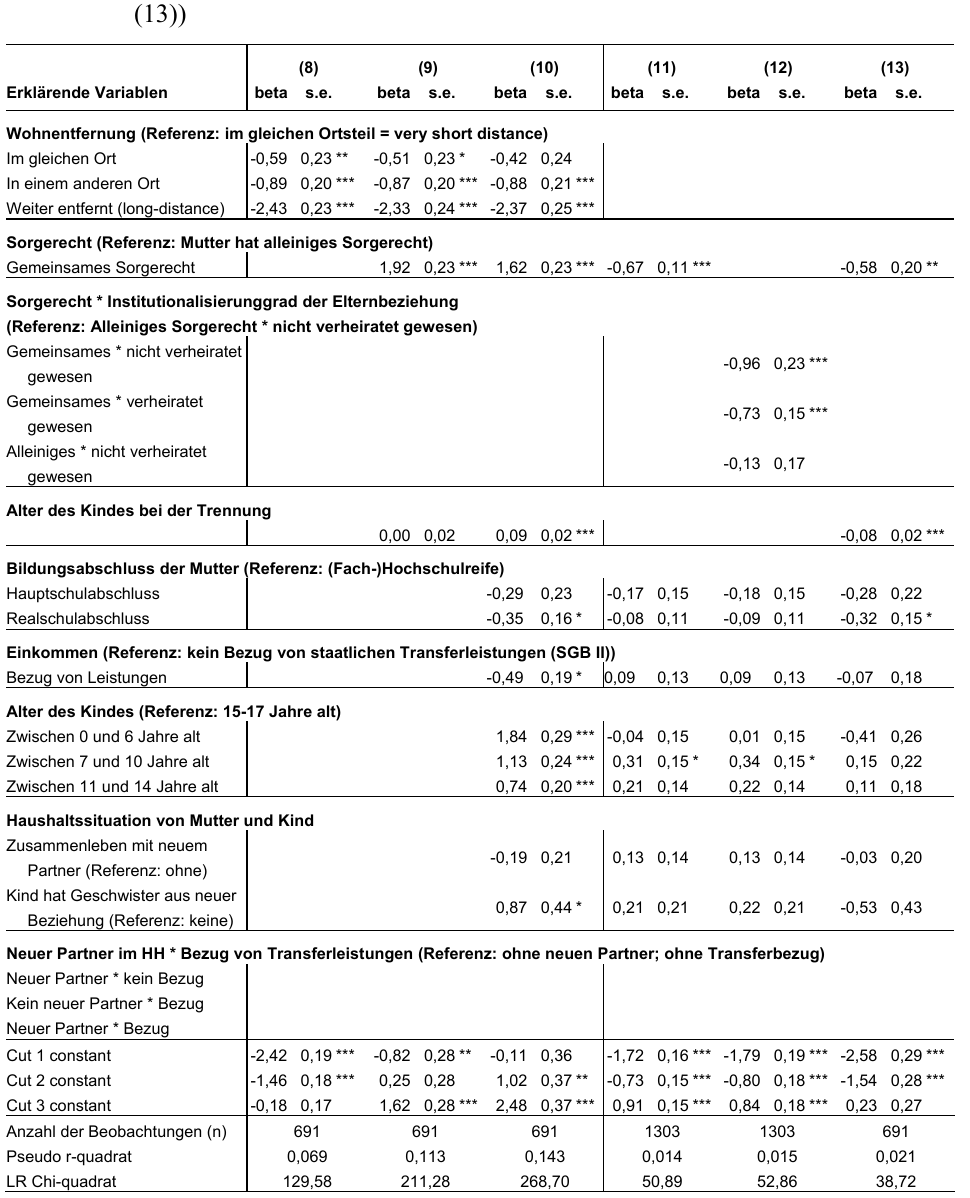
Tabelle 4 : Determinanten der Kontakthäufigkeit für „Eltern, die miteinander verheiratet waren“ (Modelle (8), (9), (10)) und der Wohnentfernung (Modelle (11),